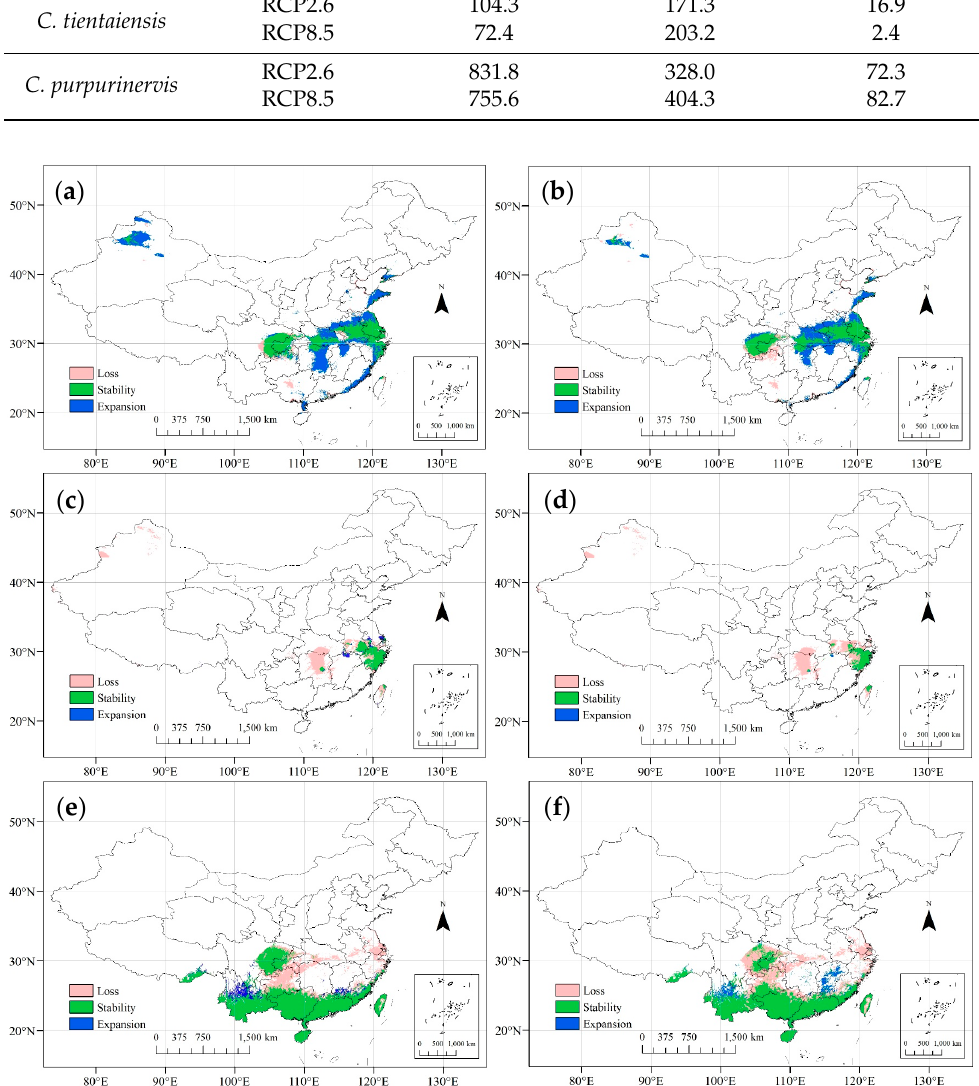
Figure 4. Predicted changes in the climatically suitable habitat area of three Carpinus species under different climate change scenarios. C. oblongifolia suitable habitats ( a , b ), C. tientaiensis suitable habitats ( c , d ), and C. purpurinervis suitable habitats ( e , f ) in the 2040–2061 under the RCP2.6 (left) and RCP8.5 (right), respectively. Table 4. Predicted changes in the climatically suitable habitats area (km 2 ) of three Carpinus species under different climate change scenarios (RCP2.6 and RCP8.5 in the years 2041-2060).